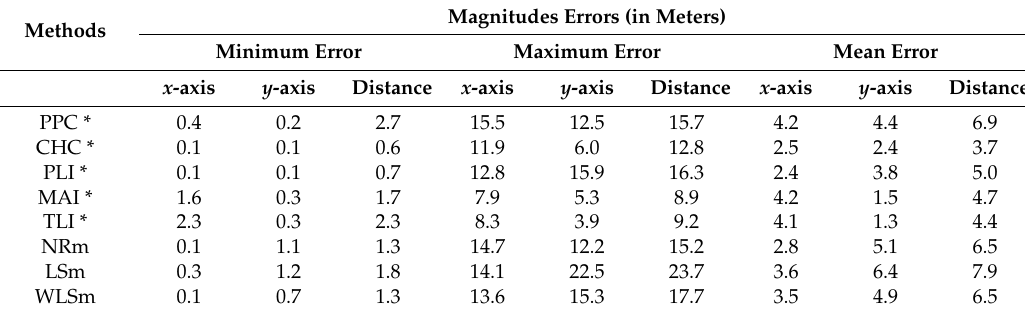
Table 1. Magnitude of errors in the experimental cases.